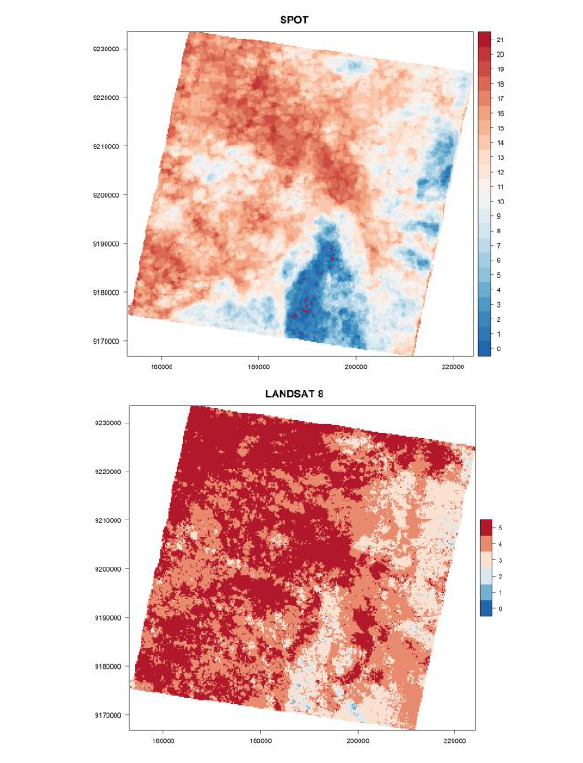
Figure 3. Cloud free data frequency maps with SPOT (top) and Landsat-8 (bottom).